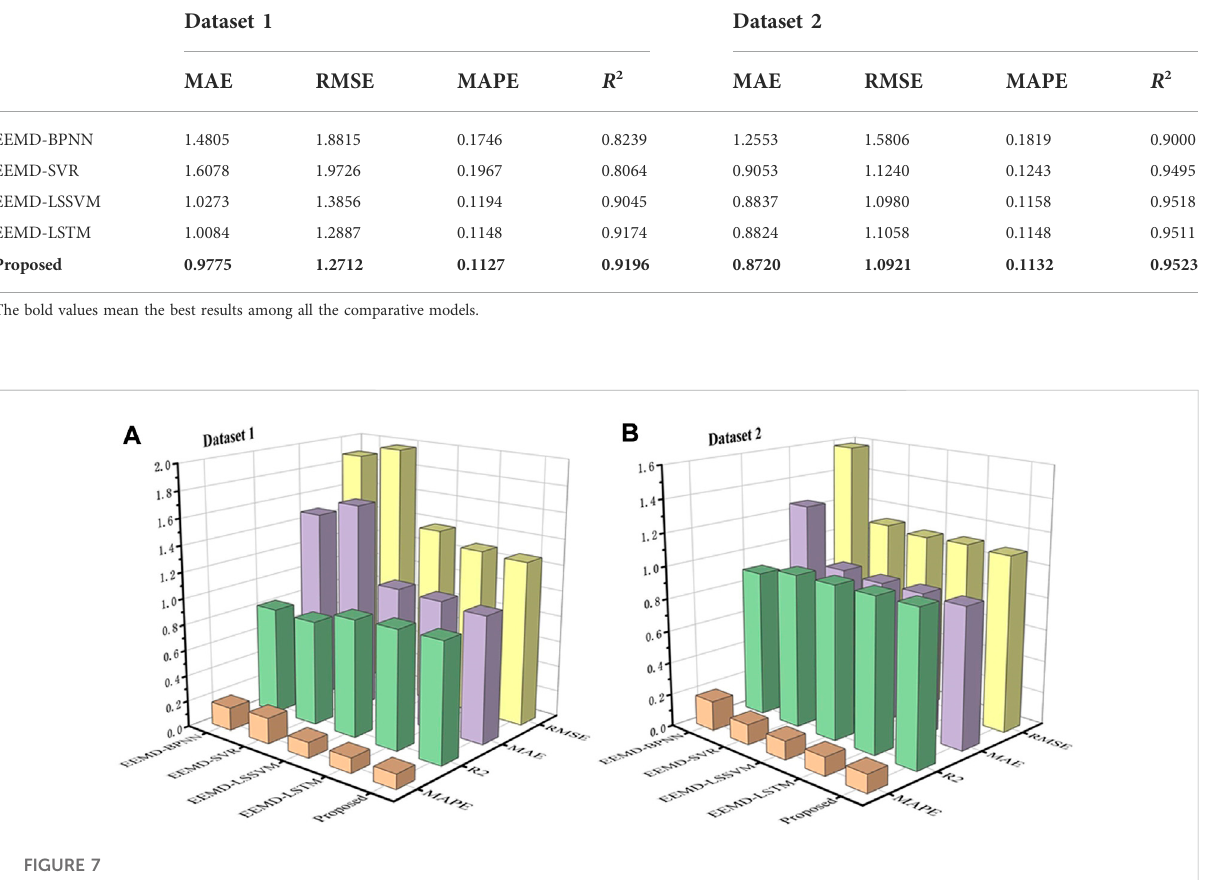
TABLE 6 Performance metrics of fi ve models on experiment Ⅱ .